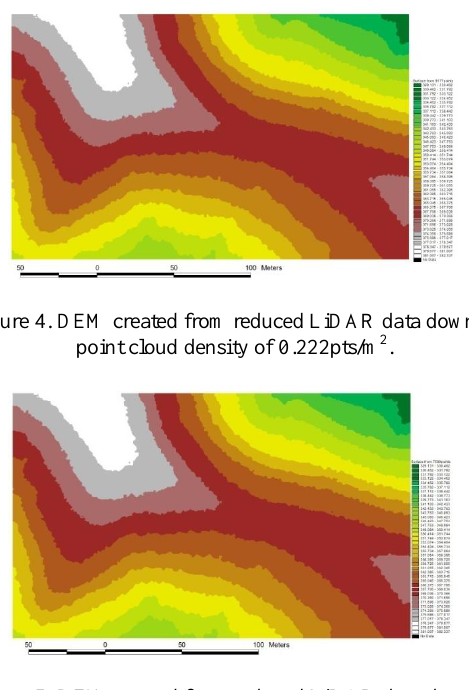
Figure 5. DEM created from reduced LiDAR data down to point cloud density of 0.184pts/m 2 .